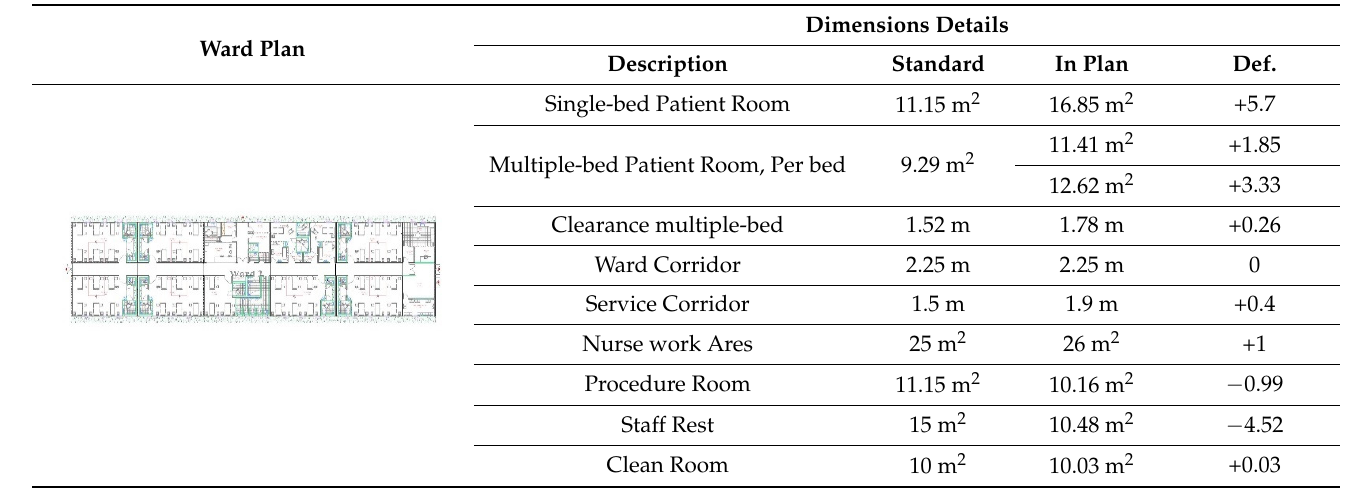
Table 9. Dimensional requirements of the wards compared to standards.